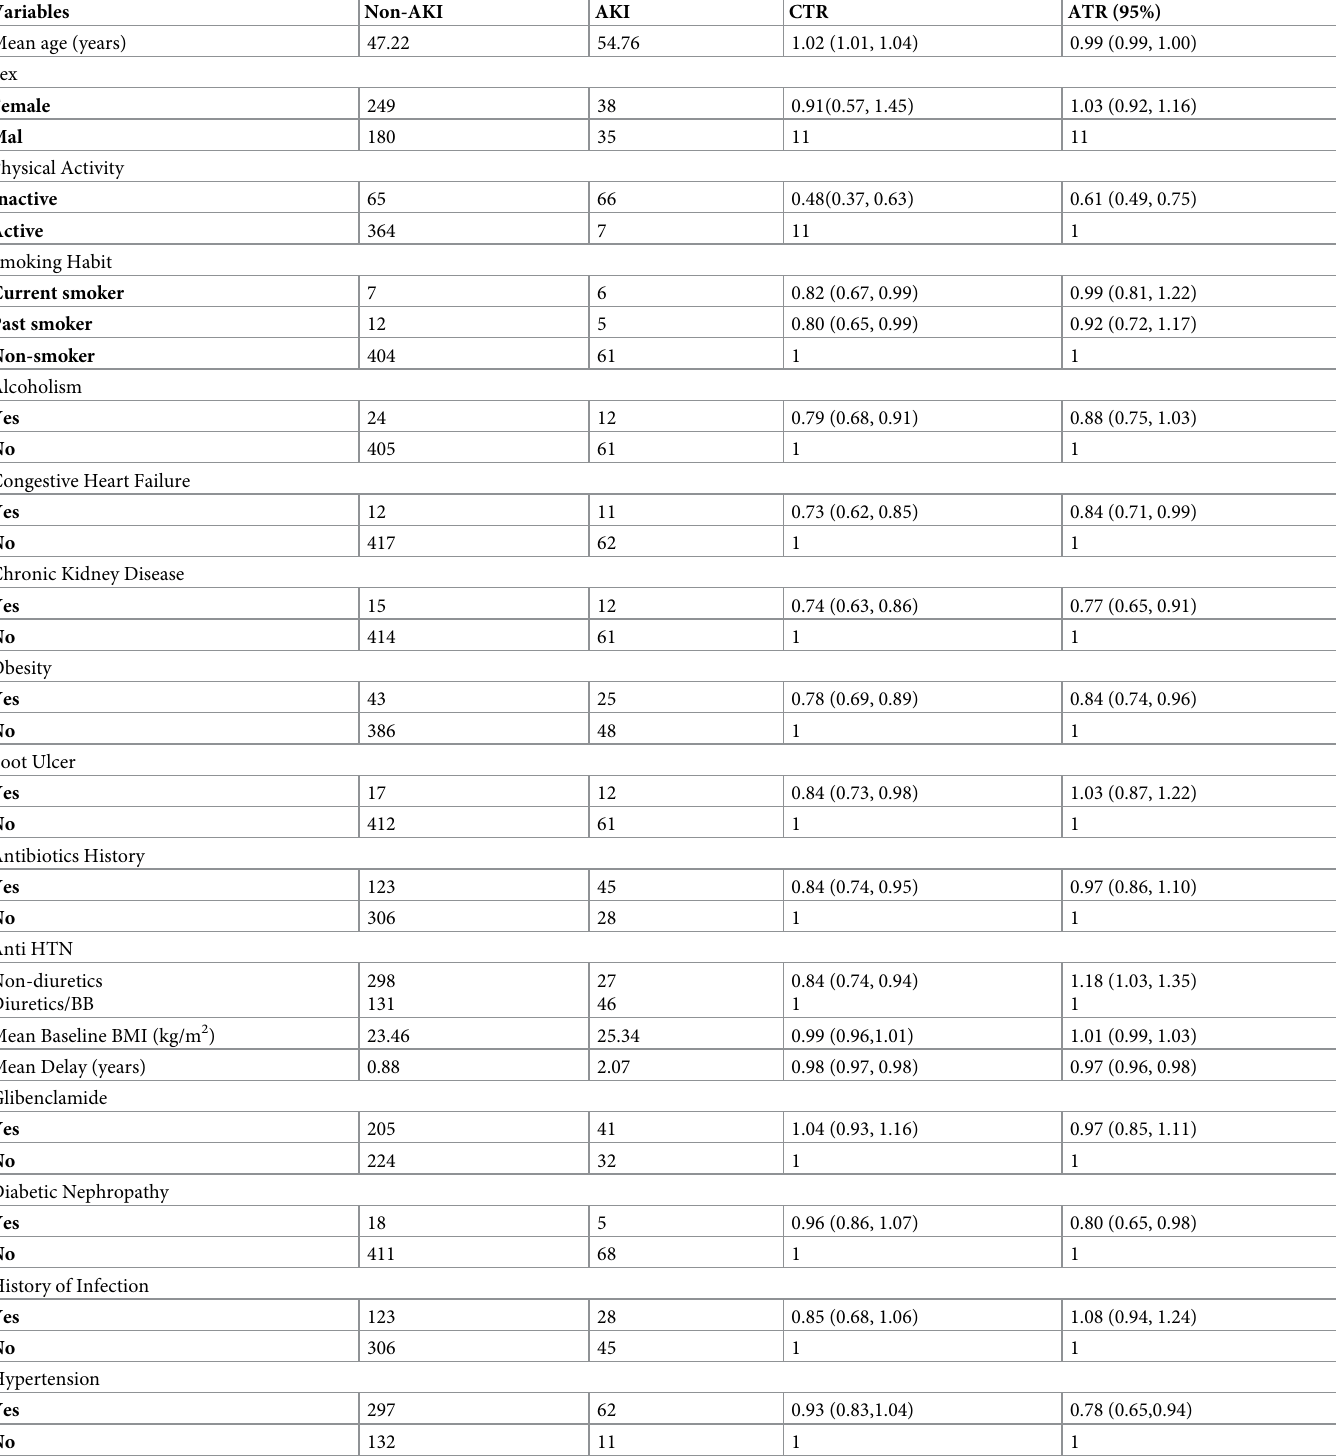
Table 3. Multivariable regression among T2D patients at government hospitals in East Ethiopia, from 2013 to